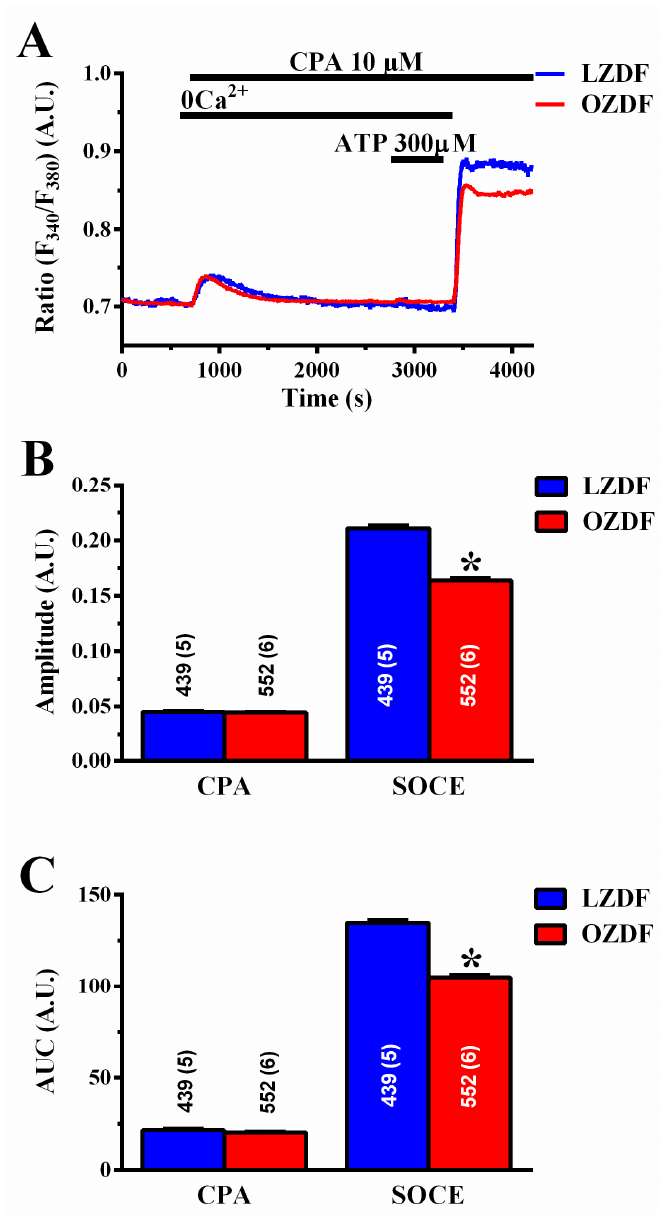
Figure 5. CPA-induced SOCE, but not endogenous Ca 2 + release, is reduced in native aortic endothelium of obese Zucker diabetic fatty rats. ( A ) Representative recordings of the “Ca 2 + add-back” protocol obtained from native aortic endothelium of LZDF and OZDF rats challenged with 10 µ M CPA. To confirm ER Ca 2 + pool depletion by CPA, 300 µ M ATP was applied in the continuous presence of CPA and in the absence of extracellular Ca 2 + after recovery of CPA-induced intracellular Ca 2 + mobilization. ( B ) Mean ± SE of CPA-induced endogenous Ca 2 + release and SOCE amplitude recorded in native aortic endothelium of LZDF and OZDF rats challenged with 10 µ M CPA. ( C ) Mean ± SE of the AUC of the two distinct components (i.e., endogenous Ca 2 + release and SOCE) of the Ca 2 + response to 10 µ M CPA in LZDF and OZDF rats. The asterisk indicates p < 0.05, Mann-Whitney